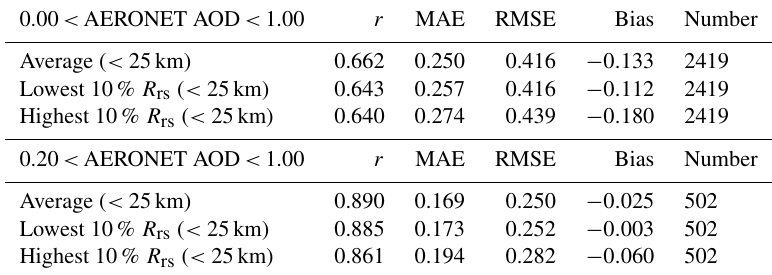
Table 2. Statistics of MISR ANG retrievals as compared to